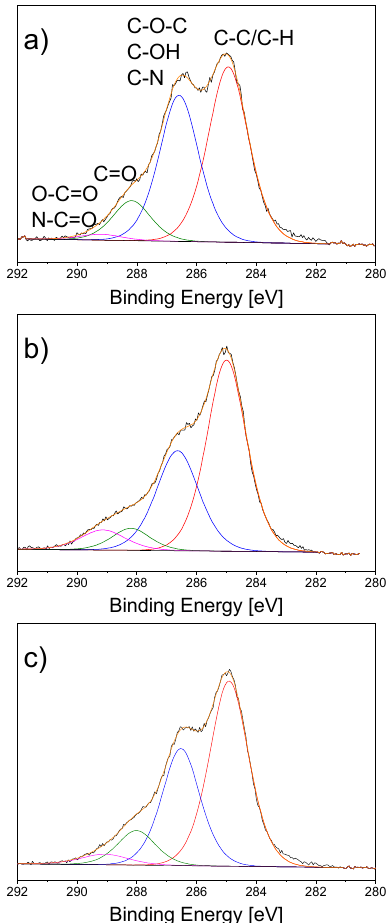
Figure 6. XPS C1s high-resolution spectra of ( a ) blank chitosan and chitosan / Ag NP composites prepared using a plasma-solution system with ( b ) the liquid anode, and ( c ) the liquid cathode. Treatment time, 30